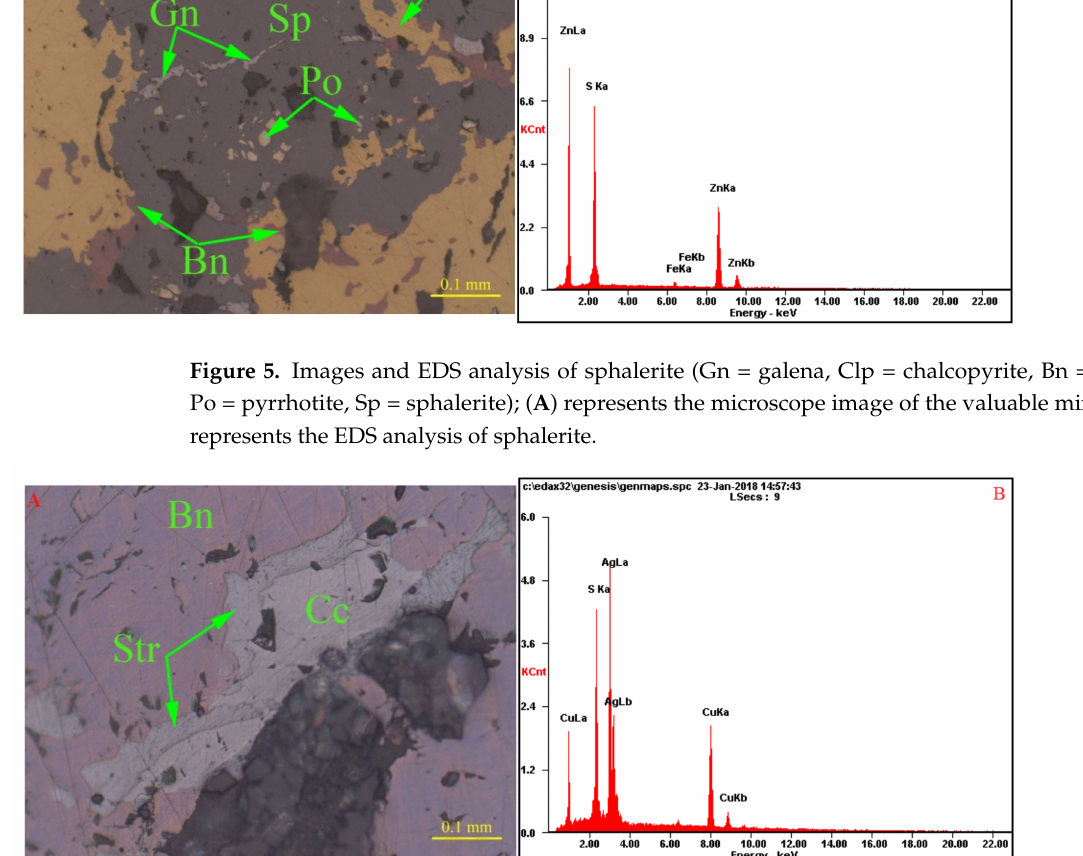
Figure 6. Images and EDS analysis of stromeyrite (Bn = bornite, Cc = Chalcocite, Str = Stromeyerite). ( A ) represents the microscope image of the silver mineral; ( B ) represents the EDS analysis of the silver